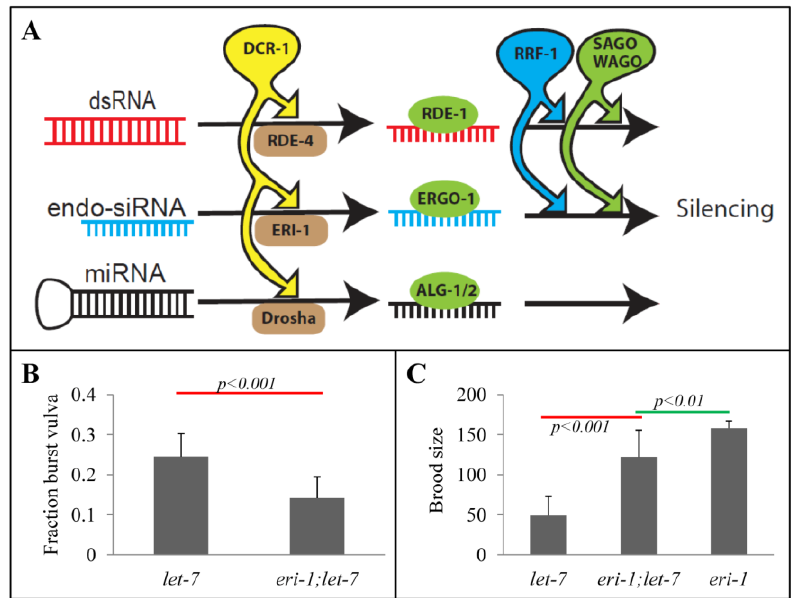
Figure 1. eri-1 dependent let-7 reduction-of-function phenotypes . (A) Schematic of proposed competing small RNA pathways. MicroRNAs, experimentally introduced double stranded RNAs (dsRNA), and endogenous short interfering RNAs (endo-siRNAs) were proposed [26] to compete for limiting shared resources, including the single C. elegans DICER homolog, dcr-1 , the RNA-directed RNA polymerase RRF-1, and the secondary Argonautes (SAGOs), including the C. elegans specific worm Argonautes (WAGOs) that mediated siRNA-dependent silencing. The competition for limiting shared resources implies that reduced flux through one pathway allows for increased access to limiting resources for the other pathways. (B) Spontaneous vulva bursting rate of let-7(n2853) single (n = 9) and eri-1(mg366);let-7(n2853) double (n = 10) mutants at 15 °C. The average of n complete broods is shown. The eri-1(mg366) single mutant does not exhibit any burst vulva phenotype. (C) Average brood size of let-7(n2853) and eri-1(mg366) single mutants (n = 5) and eri-1(mg366);let-7(n2853) double mutants (n = 8) at 15 °C. Standard deviations are shown. p -values are calculated by t